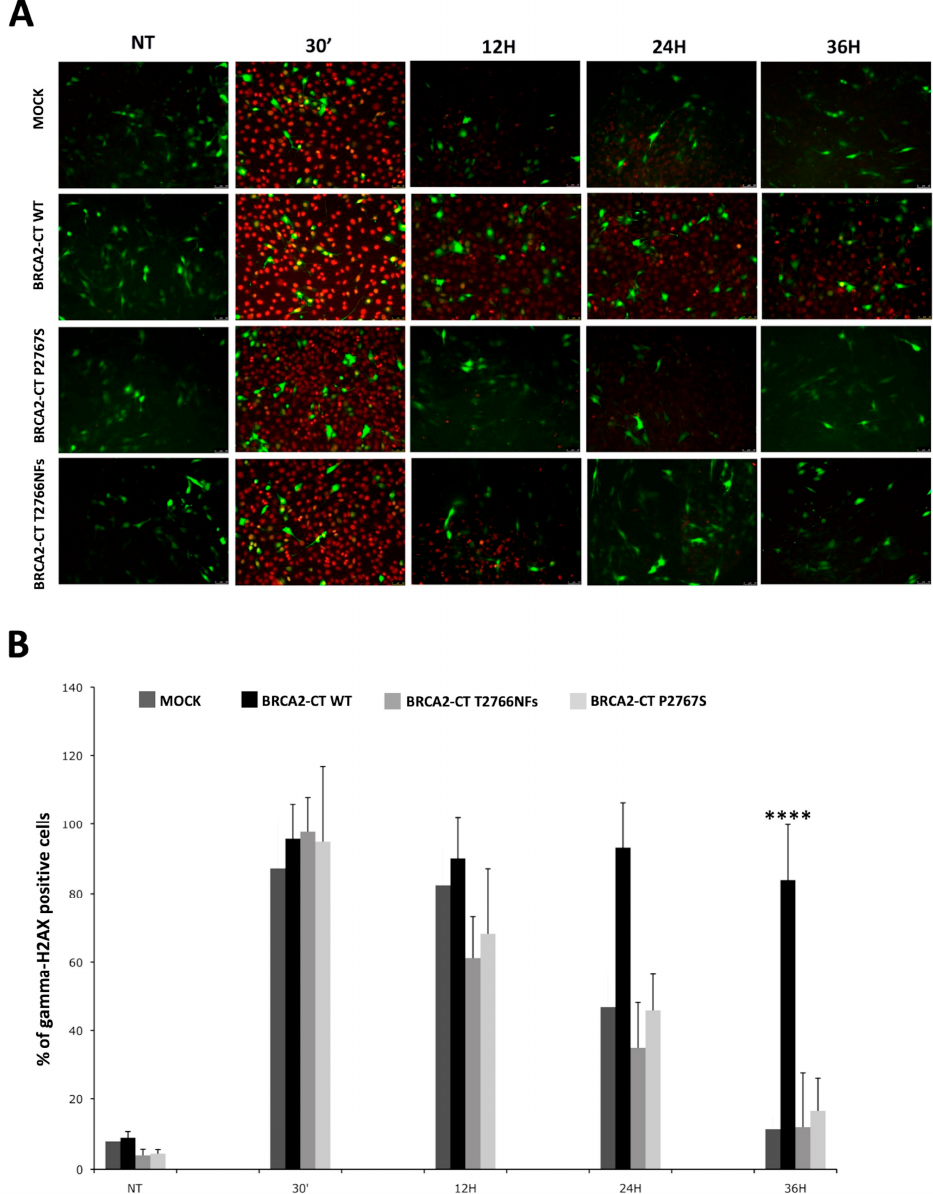
Figure 7. The DNA damage recovery assay. ( A ) Phospho-H2AX-recovery kinetics representative figures. GFP (green) and phospho-H2AX (red) emission in transfected cells at time 0 (untreated, NT), at 30 min, 12 h, 24 h and 36 h after 5 Gy / sec irradiation (IR). At least 500 GFP / γ H2AX-positive cells were counted for each sample. Scale bars 50 µ m. ( B ) The percentage of the phospho-H2AX count. All NT cells at time 0 showed basal levels of histone H2AX phosphorylation: Mock 7.6%, BRCA2-CT wt 8.6%, BRCA2-CT P2767S 4.3% and BRCA2-CT T2766NFs 3.8%. Thirty minutes after IR, the percentage of H2AX phosphorylation was: mock 87.2%, BRCA2-CT wt 95.7%, BRCA2-CT P2767S 94.8% and BRCA2-CT T2766NFs 97.7%. Twelve hours after IR, the values were: Mock 82.4%, BRCA2-CT wt 90.1%, BRCA2-CT P2767S 68.1% and BRCA2-CT T2766NFs 61.2%. At 24 h, BRCA2-CT P2767S showed 45.7% of H2AX phosphorylation, BRCA2-CT T2766NFs 34.9% and mock 46.7%. The DNA of the cells transfected with BRCA2-CT wt showed 93.2% of phospho-H2AX. The percentage of γ -H2AX positive cells at 36 h after IR was 16.5% in BRCA2-CT P2767S, 11.6% in BRCA2-CT T2766NFs and 11% in the mock cells but remained very high in the BRCA2-CT wt cells, namely 83.9% of H2AX phosphorylation (**** = 2.4 × 10 − 11 ; p ≤ 0.0001). Differences between BRCA2-CT P2767S, BRCA2-CT T2766NFs and the mock-transfected samples were not statistically significant.